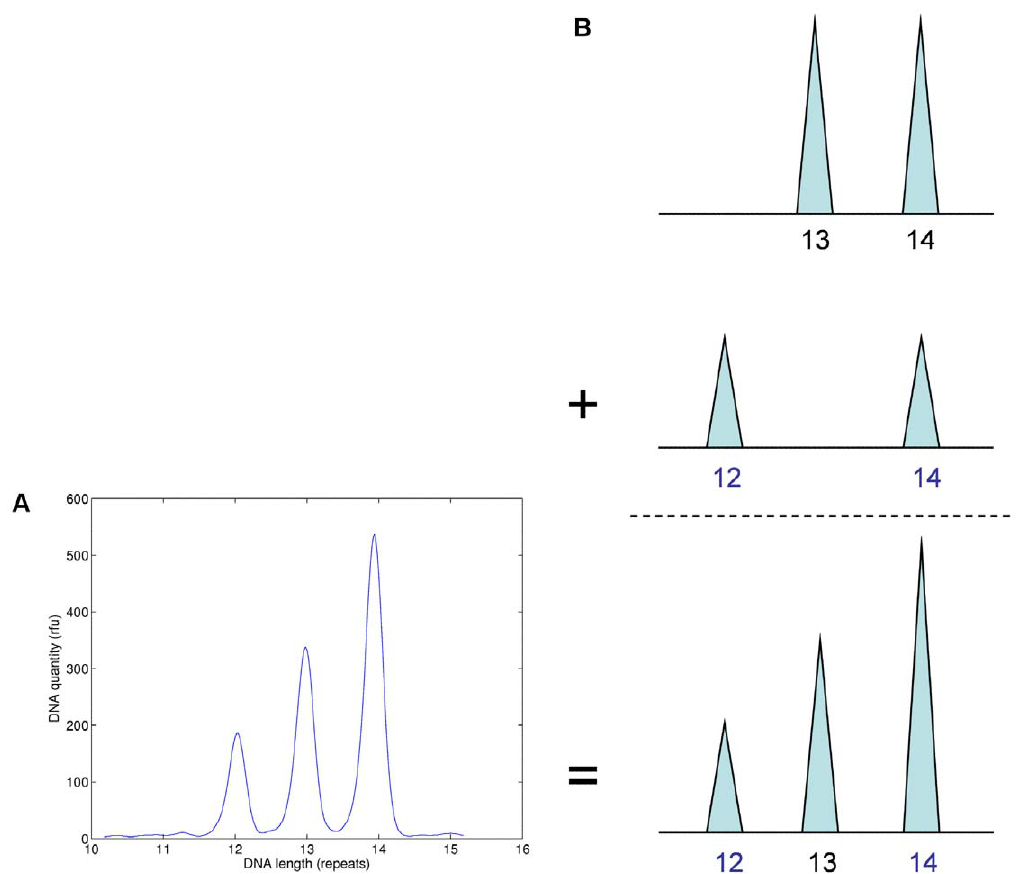
Figure 1. STR data can be modeled by linear superposition of genotype patterns. (a) The DNA sequencer data signal shows the Penta D STR locus for a 0.25 ng 30% culprit DNA sample C3. (b) Linearly combining genotype values ½ 13 14 (cid:1) and ½ 12 14 (cid:1) in respective 70% and 30% proportions forms a model of the observed allele peak height pattern.